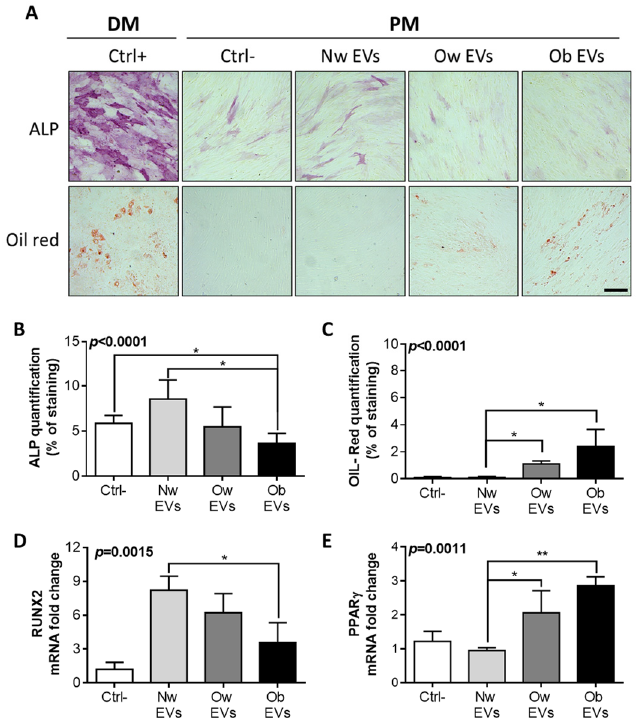
Figure 3. ( A ) MSC were treated for 21 days with canonical differentiation medium (DM) to achieve a complete osteogenic (upper panel) and adipogenic (lower panel) differentiation evaluated by al- kaline phosphatase (ALP) and oil red staining, respectively. This condition served as positive control (Ctrl+) of the experiment. In parallel, MSC were cultured for 21 days in a proliferation medium (PM) and treated every 3 days with EVs collected from children with normal weight (NW EVs), overweight (Ow EVs) and obesity (Ob EVs), and compared to control condition (Ctrl-) with no EV treatment. These samples were also stained for ALP and oil red to assess osteogenic (upper panel) and adipogenic (lower panel) differentiation, respectively. Scale bar: 200 μ m. Quantification of the percentage of ALP ( B ) and oil red ( C ) staining in MSCs treated with EVs in PM for 21 days. RT-PCR for the expression of osteoblastic master-gene Runx2 ( D ) and the adipogenic master-gene PPAR- γ ( E ) in MSCs treated with NW, Ow and Ob EVs for 21 days, normalized versus the housekeeping GAPDH. * p < 0.05; ** p < 0.01.